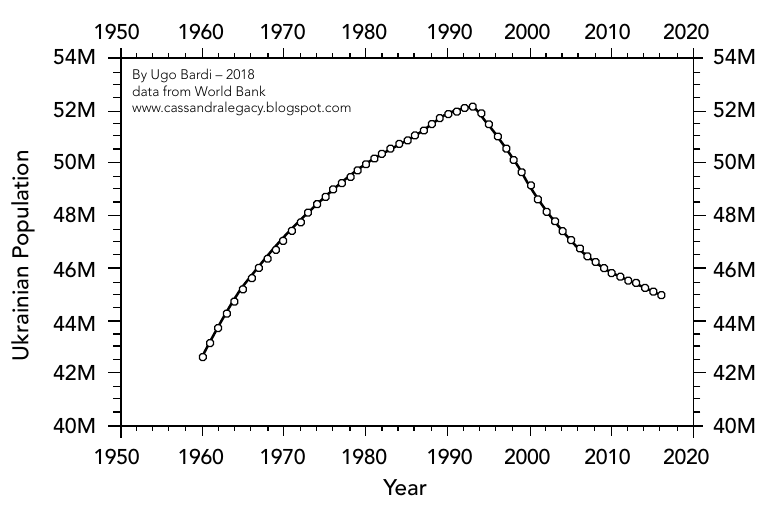
Fig. 7 – Ukrainian population – data from the World